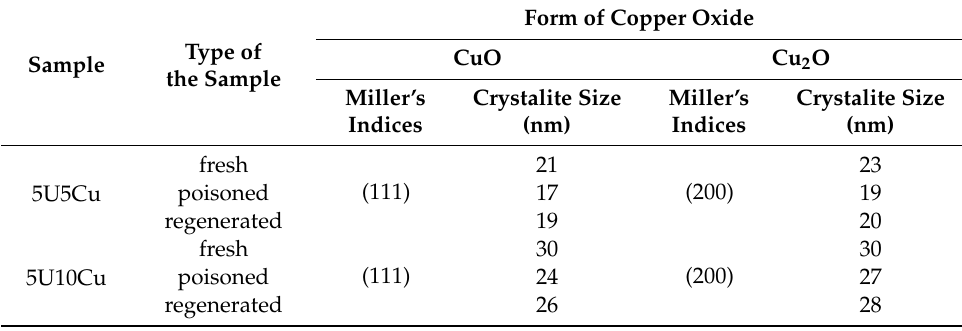
Table 2. The lateral size ( L a ) and stacking height ( L c ) parameters for selected samples. Sample